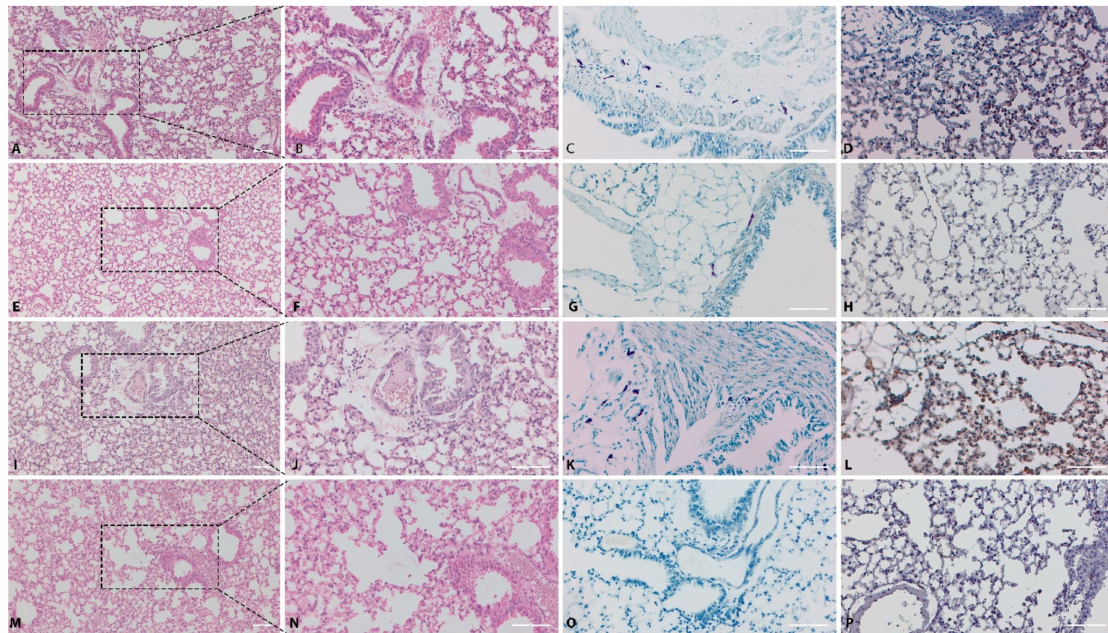
Figure 6. Histological and immunohistochemical findings of lungs from experimental mice groups. PREV Group: his- tological changes of pulmonary parenchyma, HE stain ( A , B ); TB staining showing numerous peribronchiolar mast cells ( C ); NF-kB p65 immune expression in the lungs, IHC stain ( D ). RESCUE group: Lung, HE stain ( E , F ) and TB stain ( G ); NF-kB p65 immunoexpression in the lungs, IHC stain ( H ). ASTHMA group: Lung, HE stain ( I , J ) and TB stain ( K ); NF-kB p65 immunoexpression in the lungs, IHC stain ( L ). CONTROL group: Lung, HE stain ( M , N ) and TB stain ( O ); NF-kB p65 immunoexpression in the lungs, IHC stain ( P ). Bar = 50um. Abbreviations: HE = hematoxylin-eosin, TB = toluidine blue, NF-kB p65 = nuclear factor kappa B p65, IHC = immunohistochemical staining, PREV = long-term low-dose vitamin D supplementation, RESCUE = short-term high-dose vitamin D supplementation, ASTHMA = positive control, CONTROL = negative